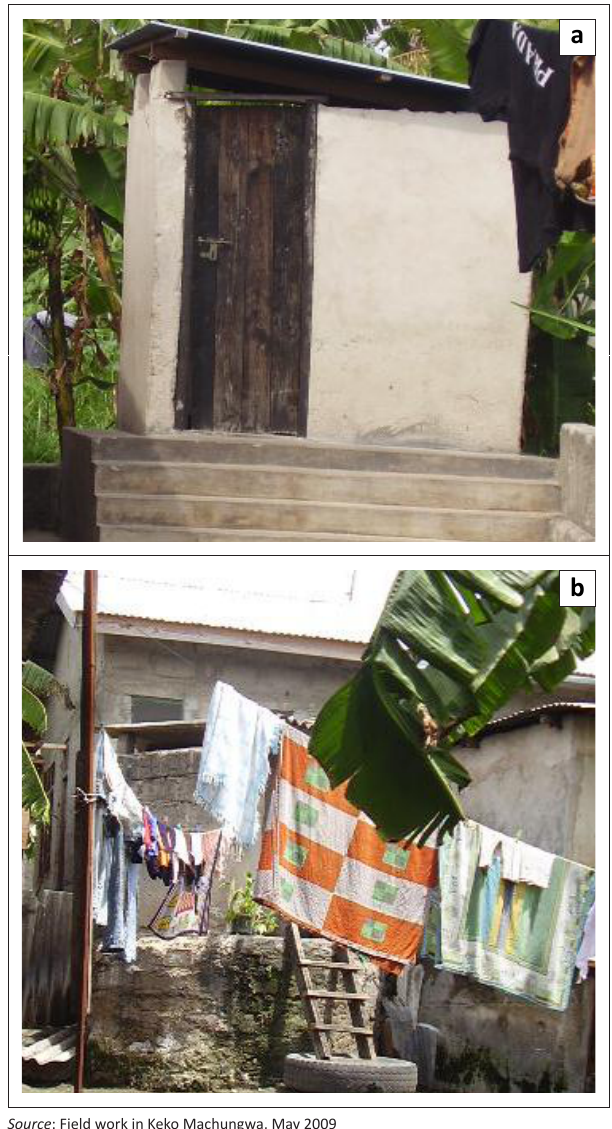
FIGURE 6 : Sandbags (a) used to prevent flooding and erosion (b).